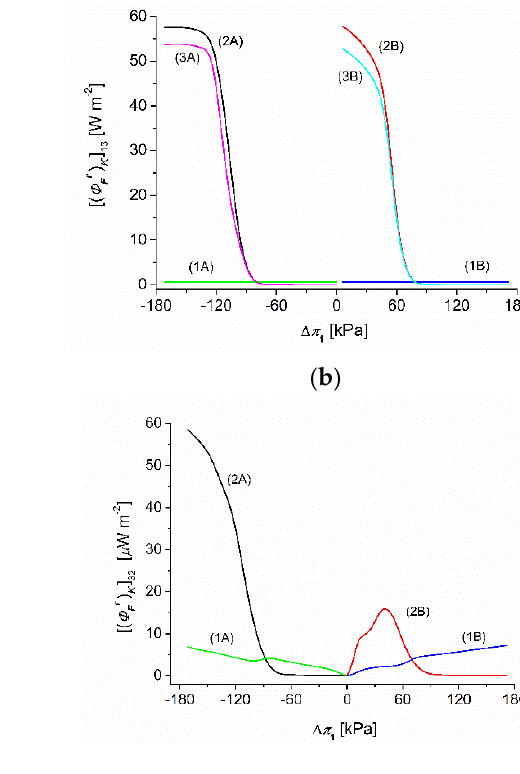
Figure 8. Total production of free energy [(𝛷 (cid:3007)(cid:3045) ) (cid:3012) (cid:3293) ] (cid:3036)(cid:3037) , ( i , j ∈ {1, 2, 3}, r = A, B) as functions of osmotic pressure difference of glucose ( ∆ π 1 ) with a constant osmotic pressure of ethanol ( ∆ π 2 = 490.3 kPa) and ∆𝑃 = 0: [(𝛷 (cid:3007)(cid:3045) ) (cid:3012) (cid:3293) ] (cid:2869)(cid:2870) = [(𝛷 (cid:3007)(cid:3045) ) (cid:3012) (cid:3293) ] (cid:2870)(cid:2869) ( a ), [(𝛷 (cid:3007)(cid:3045) ) (cid:3012) (cid:3293) ] (cid:2869)(cid:2871) = [(𝛷 (cid:3007)(cid:3045) ) (cid:3012) (cid:3293) ] (cid:2871)(cid:2869) ( b ), [(𝛷 (cid:3007)(cid:3045) ) (cid:3012) (cid:3293) ] (cid:2870)(cid:2871) ( c ), [(𝛷 (cid:3007)(cid:3045) ) (cid:3012) (cid:3293) ] (cid:2871)(cid:2870) ( d ).